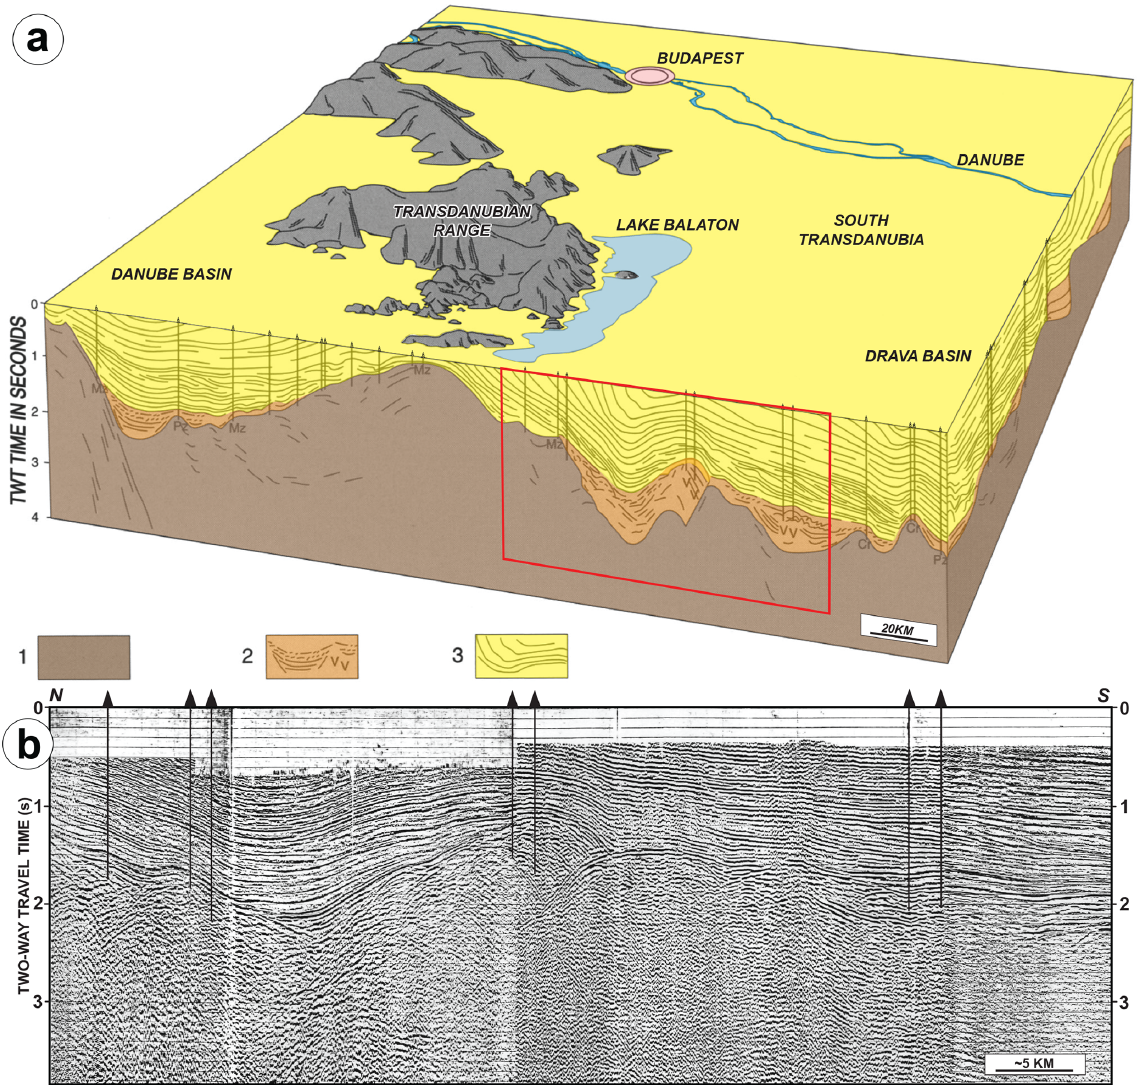
Figure 4. (a) Block diagram of the Transdanubian part of the Pannonian Basin to illustrate the structural and stratigraphic conditions and their relation to surface morphology. The regional-scale upwarping of pre-Cenozoic rocks of the Transdanubian Range north of Lake Balaton (for location, see Fig. 3) is the consequence of Pliocene to Holocene basin inversion (adapted from Horvath and Tari, 1999). Legend: 1, Mesozoic–Paleozoic bedrock; 2, mid-Miocene syn-rift strata; 3, late Miocene to Pliocene post-rift strata. (b) Composite vintage 2D seismic section (Tari, 1994; Rumpler and Horváth, 1988) as part of the regional seismic line shown above as a line drawing. The core of the young anticline in the center was drilled by wells Vése-1 and -2 and penetrated thick syn-rift Miocene strata. The overall geometry of the structure suggests that a syn-rift half-graben was inverted, just like in the case of the Budafa anticline (Fig.